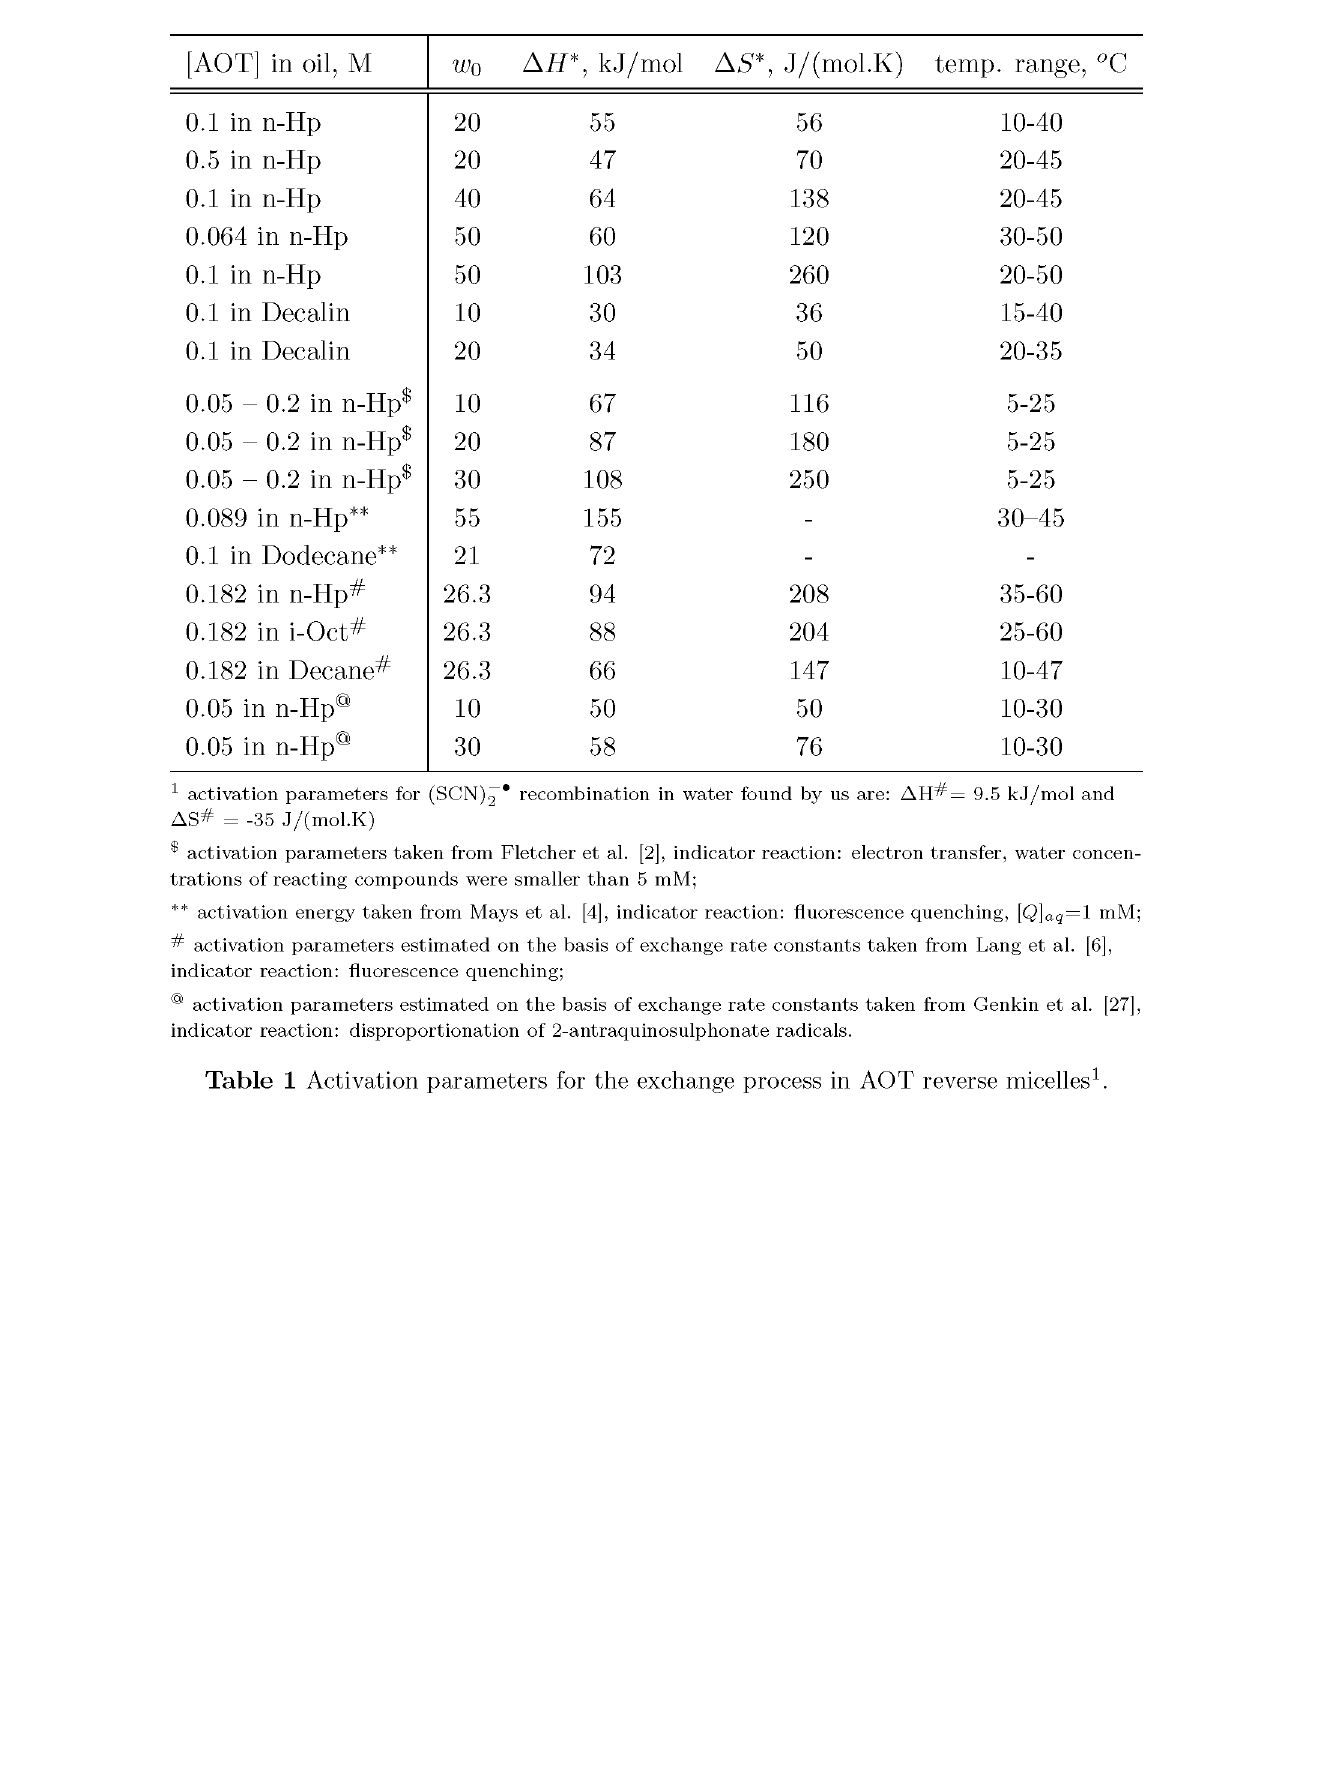
Table 1 Activation parameters for the exchange process in AOT reverse micelles